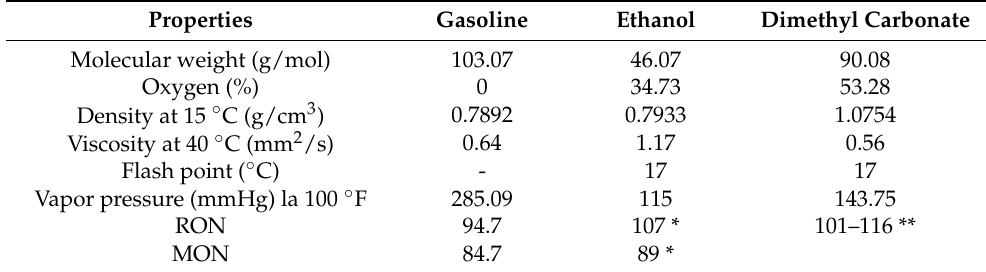
Table 2. Properties of gasoline, ethanol and dimethyl